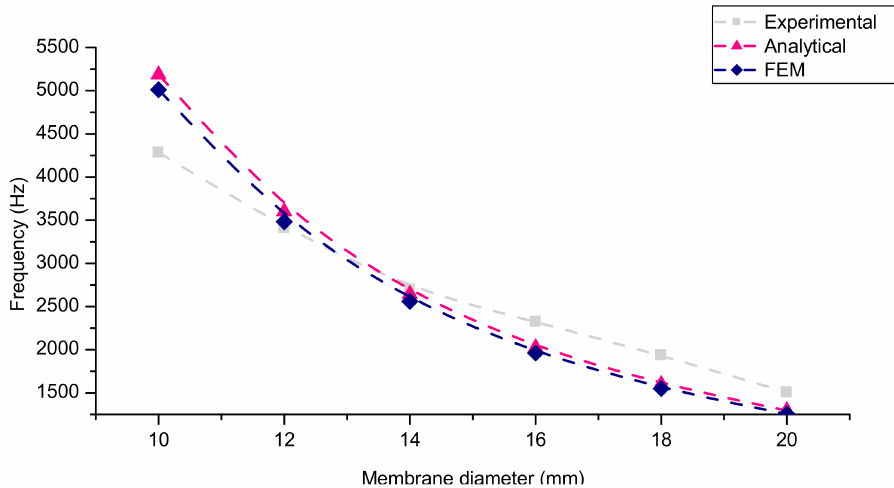
Figure 7. Resonance frequency of the first mode as a function of the membrane diameter. Comparison between the FEM model, the analytical model, and experimental